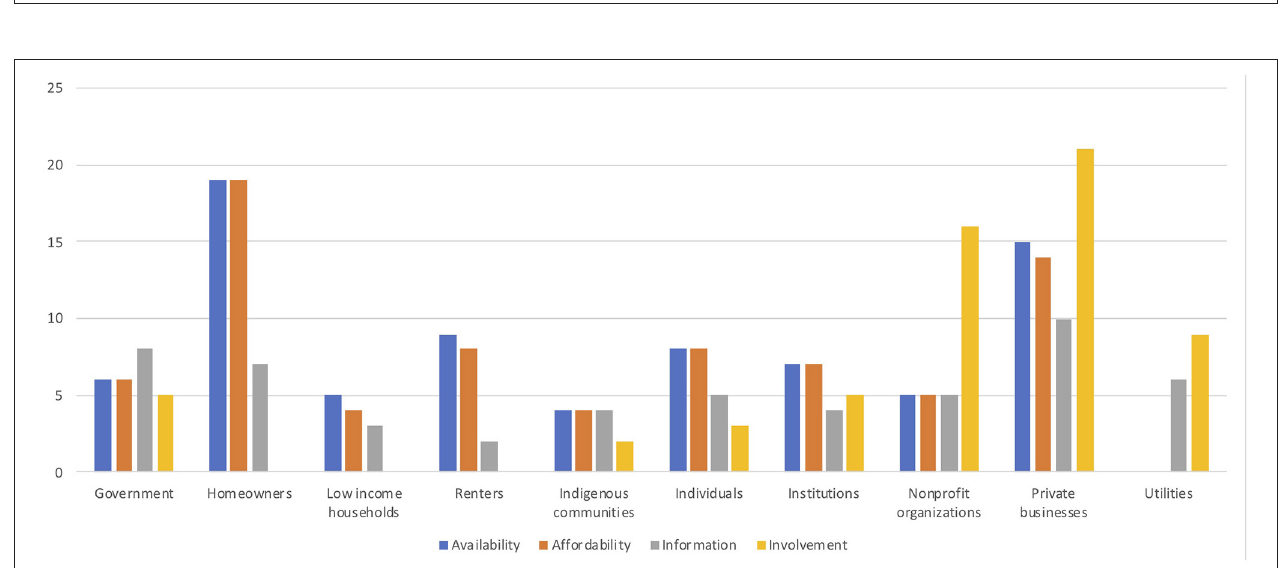
FIGURE 2 | Energy justice of government provided innovations according to user type ( n = 1,440).